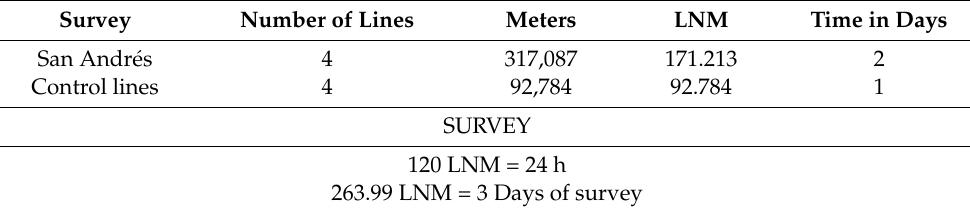
Table 2. Estimation of time of the operation, including the displacement. Activity